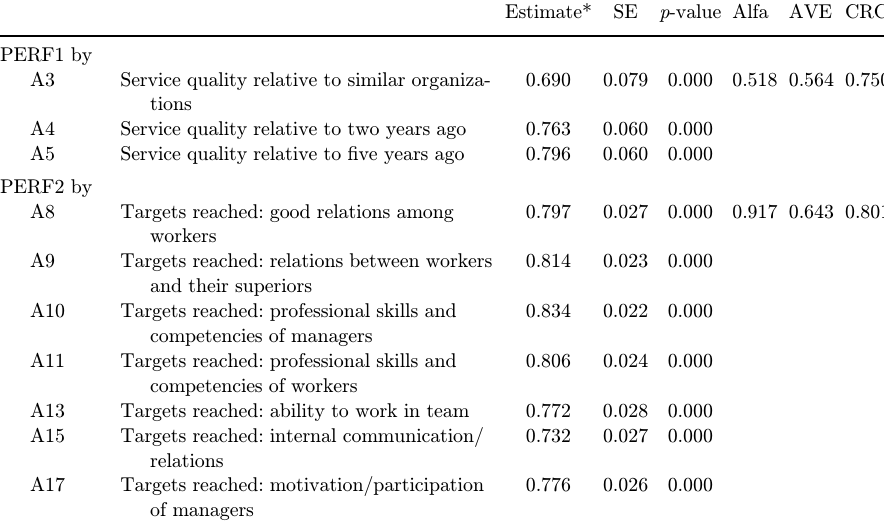
Table A.2. Results of the measurement equations models.